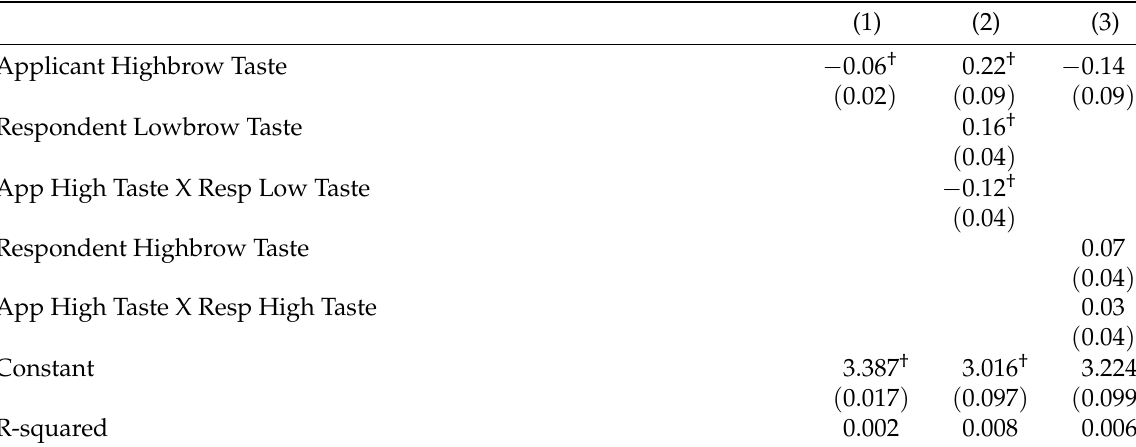
Table 5: Ordinary least squares regression measuring the effect of applicant cultural taste, interacted with respondent cultural taste, on perceptions of